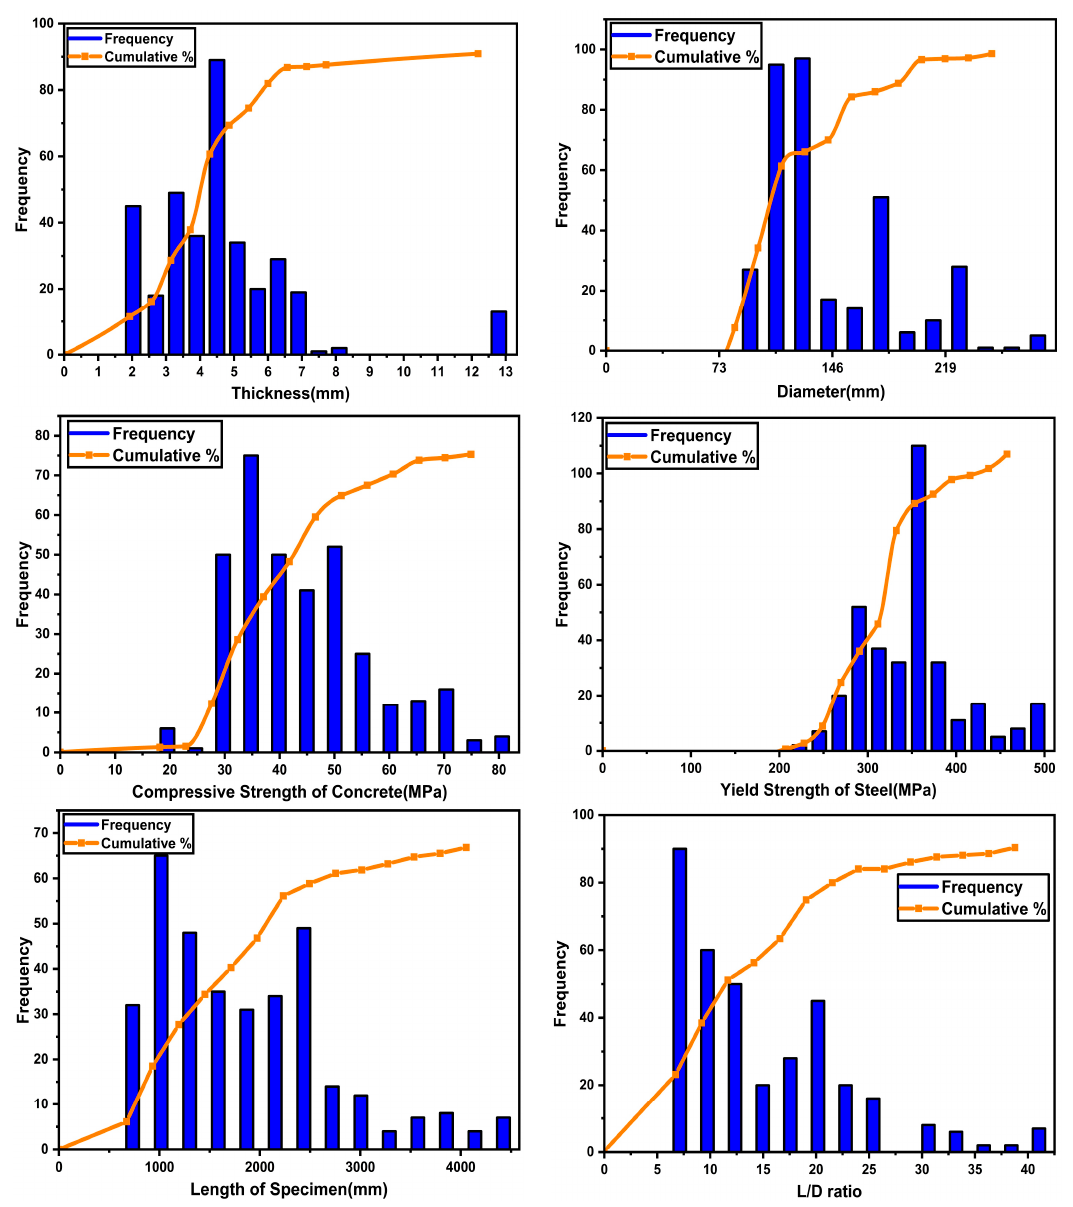
Figure 2. Histogram of the variables exercised in the establishment of the model.